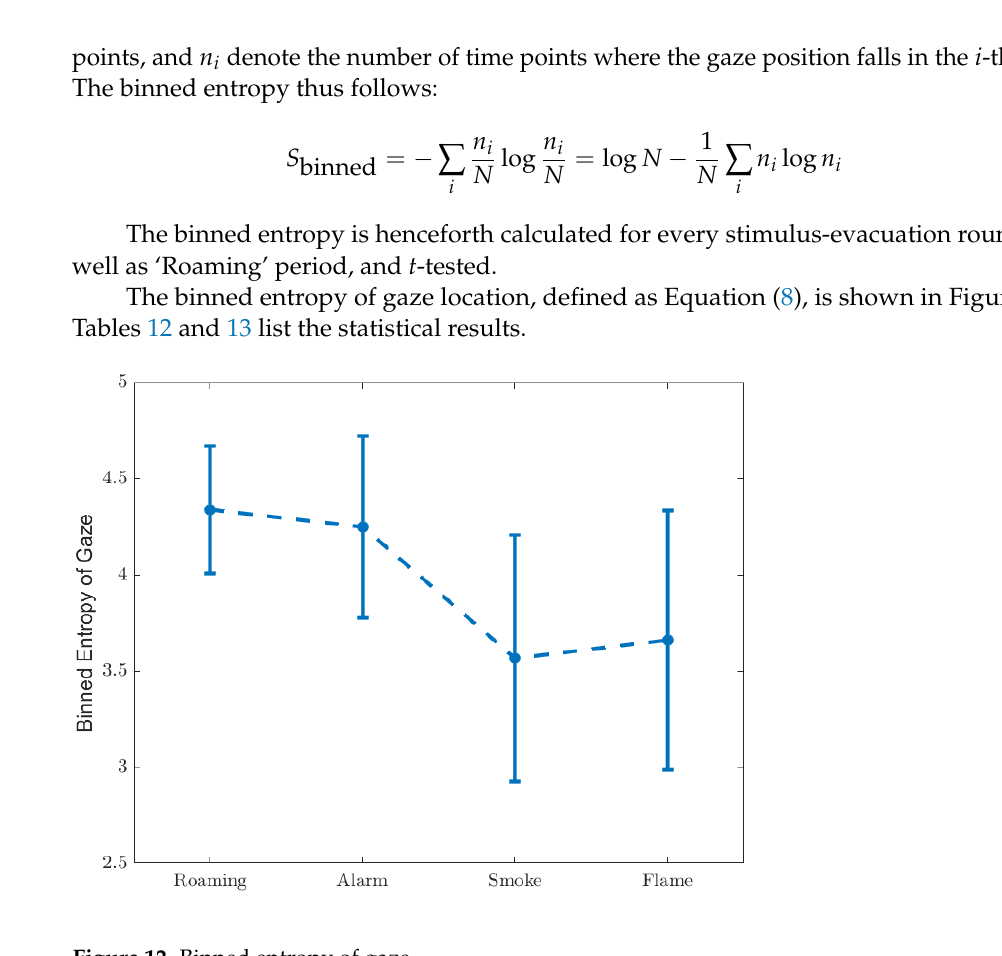
Figure 12. Binned entropy of gaze.